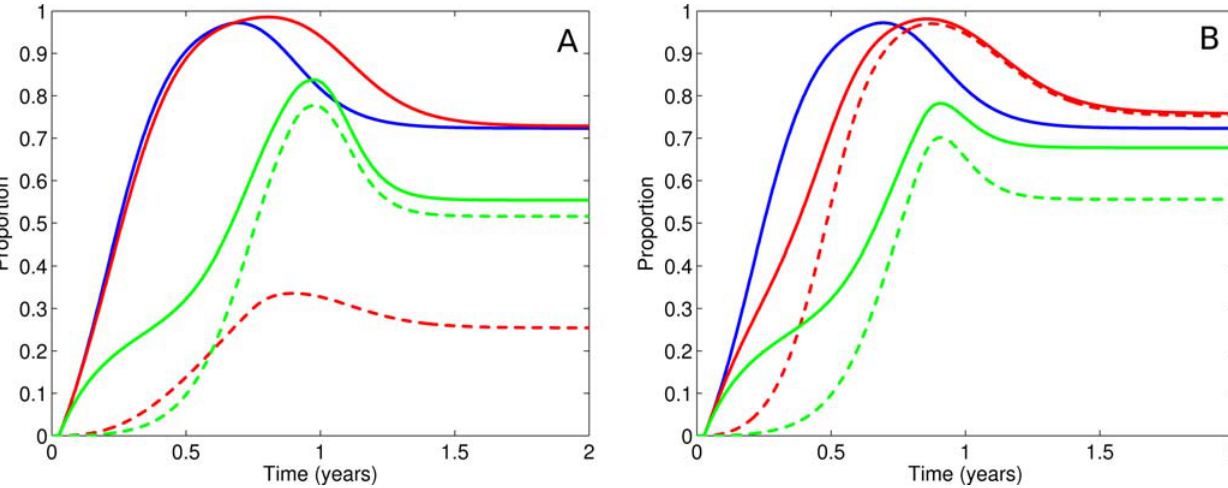
Figure 7. Strategic use of one or two drugs: the resistant proportion. a. Proportion of cumulative infections that are resistant for a 90/10 stockpile. Colours as in Figure 5a. Solid lines are all resistant strains (single-drug and multi-drug resistant). Dashed lines are multi-drug resistant strains only. Random allocation (red) is dominated by single-drug strain resistance. T&P (green) is dominated by multi-drug strain resistance, but as a proportion of all infections, there is less resistance overall. b. As for Figure 7a but for a 50/50 stockpile. Both random allocation (red) and T&P strategies (green) are dominated by multi-drug strain resistance. The T&P strategy has less resistance overall.